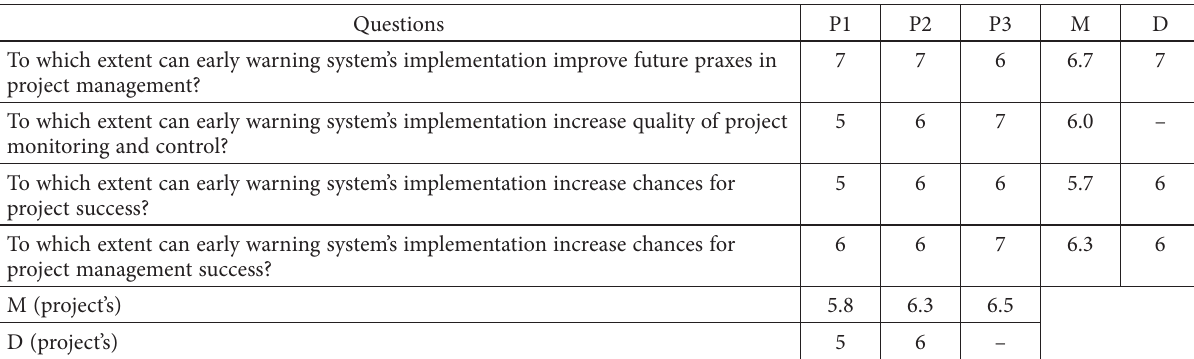
Table 8. Results of early warning system implementation attached to project manager’s perceptions on